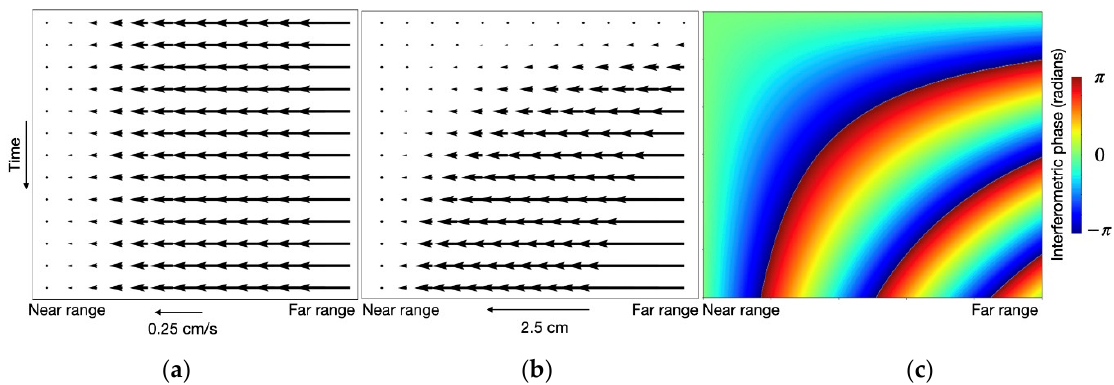
Figure 5. ( a ) Shear or convergence displacement velocity (e.g., along blue lines in Figure 4 as viewed in the stare-mode time-range geometry. ( b ) Cumulative displacement relative to t = 0. ( c ) Modeled stare-mode interferogram. The motion and interferometric change represent a maximum displacement of 2.5 cm over a 5 km range.